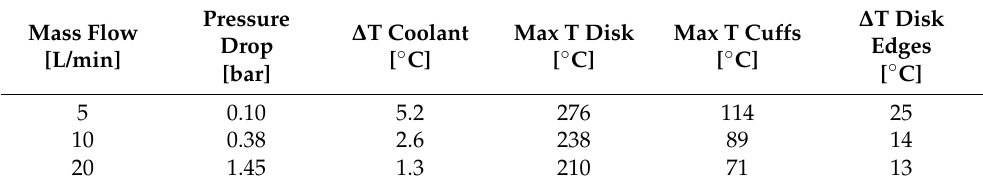
Table 1. Pressure and temperature results obtained from the sensitivity analysis regarding the inlet mass flow